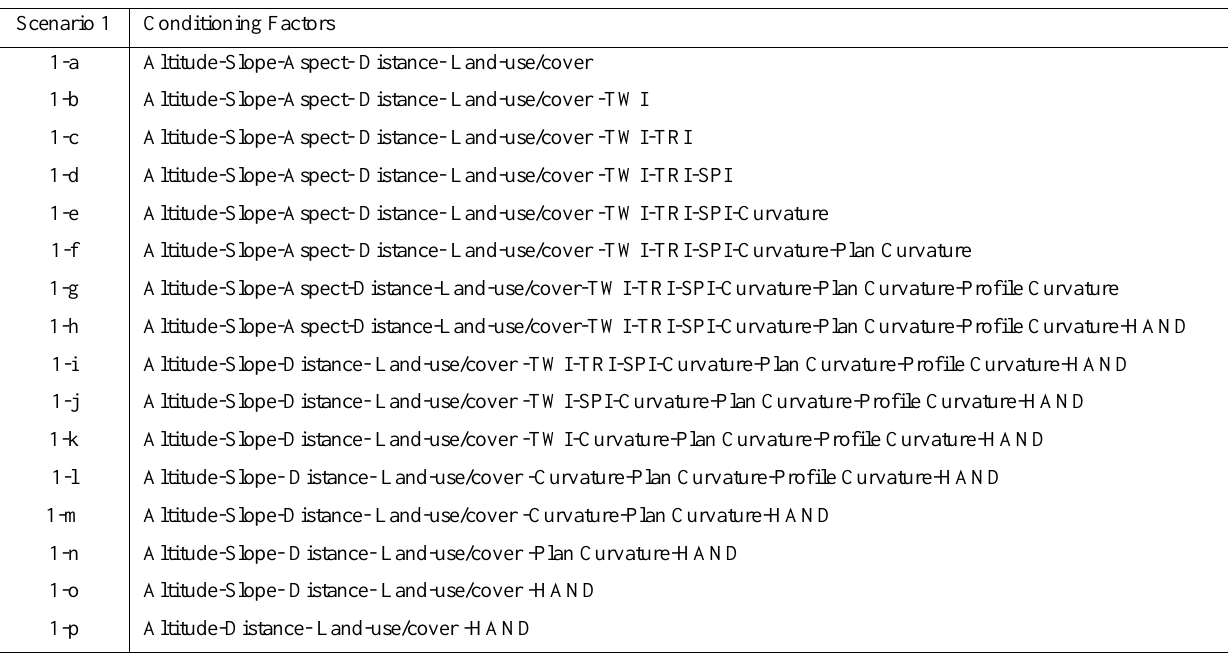
Table 1. Combinations of different conditioning factors implemented in Scenario